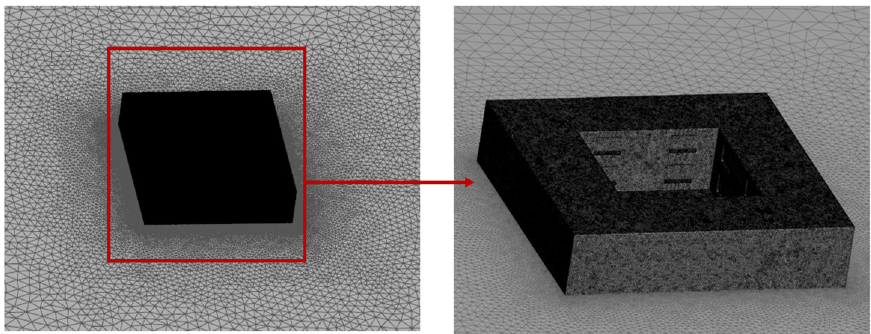
Figure 8. Meshed surfaces of the courtyard and its surrounding microclimate.